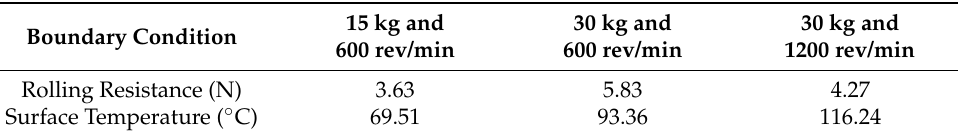
model under different rolling conditions.